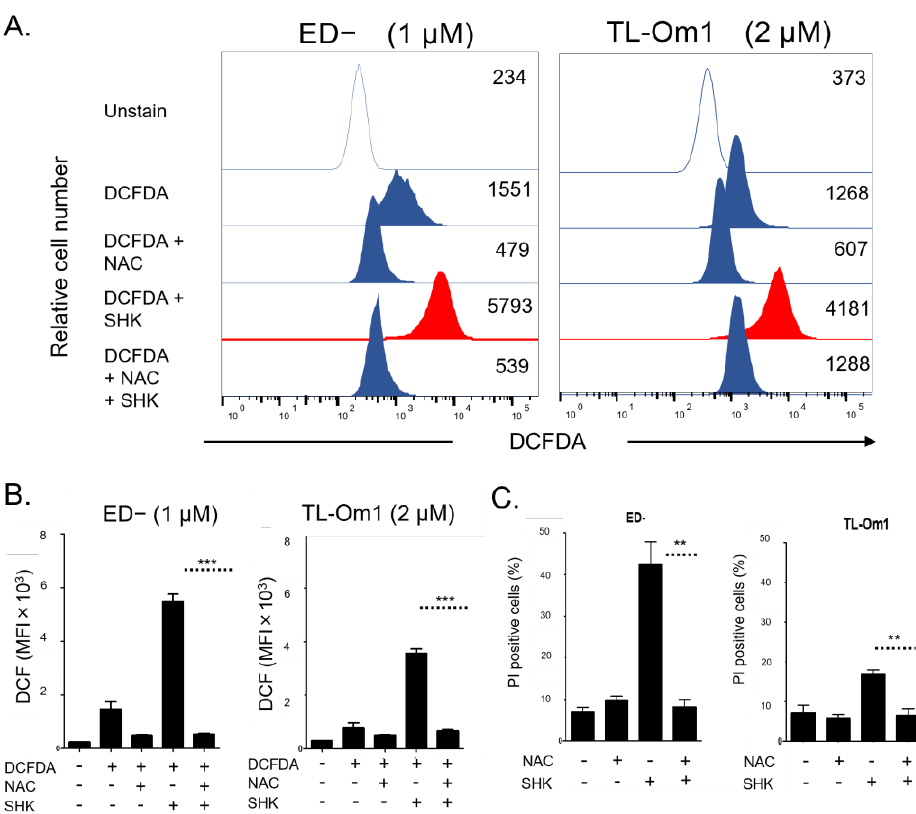
Figure 3. Accumulation of ROS and induction of cell death in ATLL cells. ( A , B ) Human ED − and TL-Om1 cells were pre-treated with/without NAC for 2 h, DCFDA (10 µ M) was added for 1 h followed by treatment with or without SHK at 1 and 2 µ M for ED − and TL-Om1, respectively. ROS levels were measured by flow cytometry. ( C ) Human ED − and TL-Om1 cells were pre-treated with or without NAC for 2 h, and subsequently treated with or without SHK at 1 and 2 µ M for ED − and TL-Om1, respectively. Cell death was determined using PI staining and flow cytometry. **p<0.01, ***p<0.001.